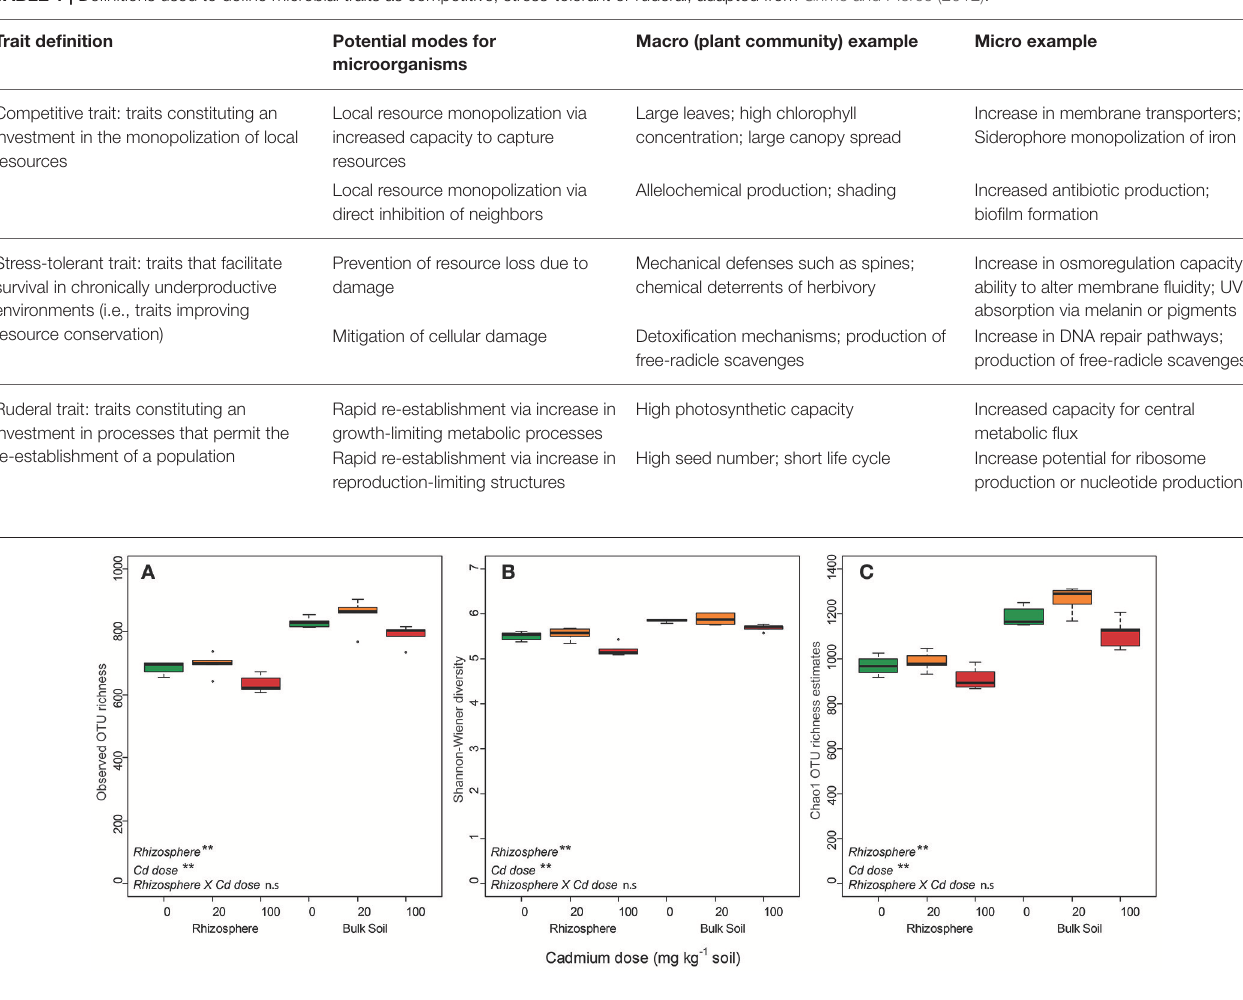
FIGURE 1 | Box plots of observed OTU richness (A) , Shannon-Wiener diversity (B) and Chao1 OTU richness estimates (C) for bacterial communities across treatments. Color is indicative of Cd treatment: Green = 0mg Cd kg − 1 soil; Amber = 20mg Cd kg − 1 soil; Red = 100mg Cd kg − 1 soil. Results of two-way ANOVAs are reported in the bottom left of panels: ** p < 0.01; n.s, not significant at p ≤ 0.05. Whiskers extend to a maximum of 1.5 × IQR beyond the box. n =